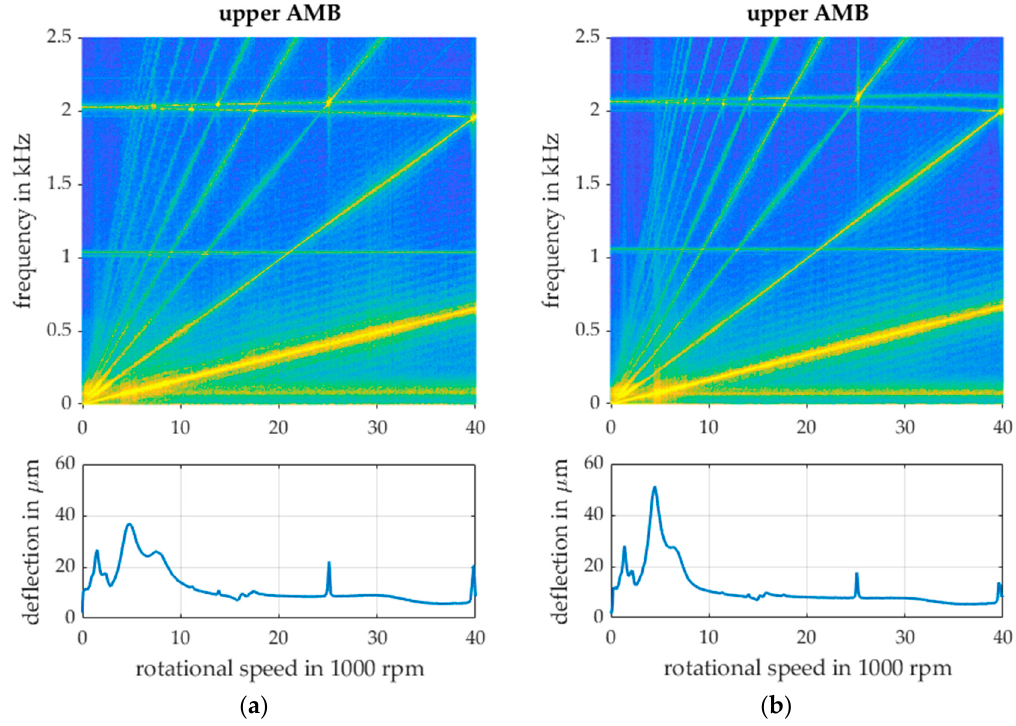
Figure 12. ( a ) Measured Campbell diagram and deflection of the rotor with a bias current of 5.67 A without specimen; ( b ) Measured Campbell diagram and deflection of the rotor with a reduced bias current of 4 A without specimen.